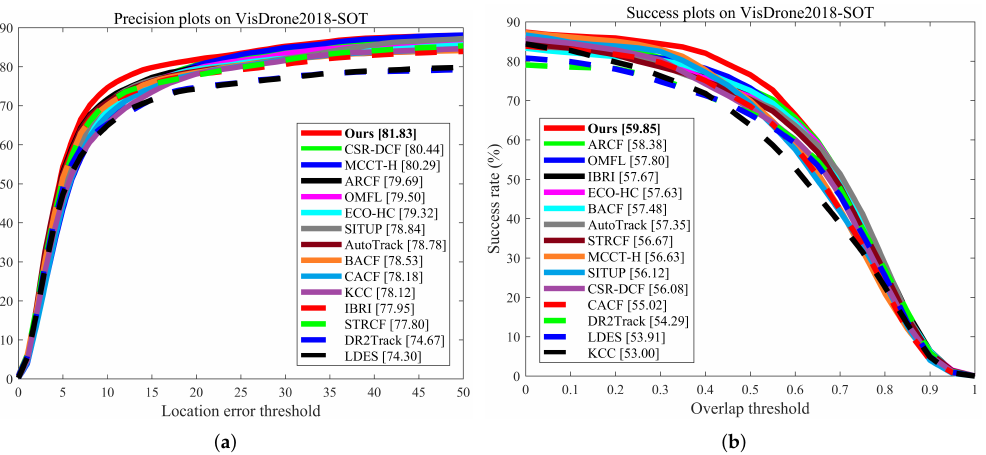
Figure 6. Overall evaluation on the VisDrone2018-SOT [46] benchmark. ( a ) Precision plots. ( b ) Suc- cess